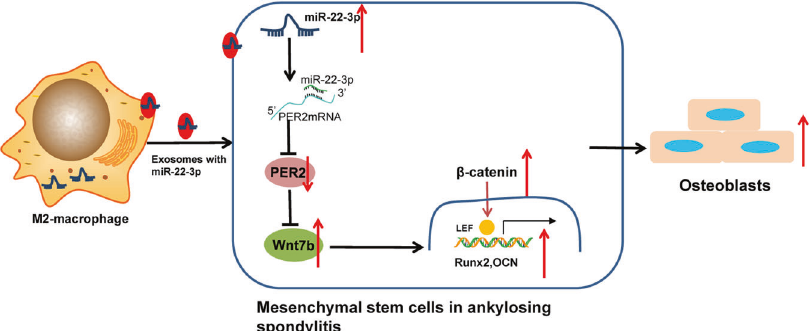
Fig. 8 Effects of M2 macrophage-derived extracellular vesicles (EVs) on the development of ankylosing spondylitis (AS) through by transferring of microRNA-22-3p. The mechanism diagram illustrating that miR-22-3p shuttled by M2-EVs promoted the osteogenic differentiation of AS-BMSCs and the resultant pathological osteogenesis in AS mice via activation of the Wnt/ β -catenin signaling pathway by targeting